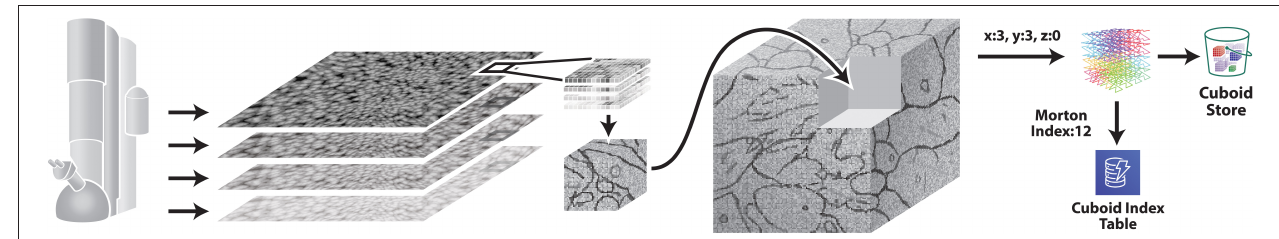
FIGURE 4 | An illustration showing how large 2D image slices generated by EM imaging are re-formatted as cuboids, which fit into a larger 3D volume, indexed using a z -order curve.